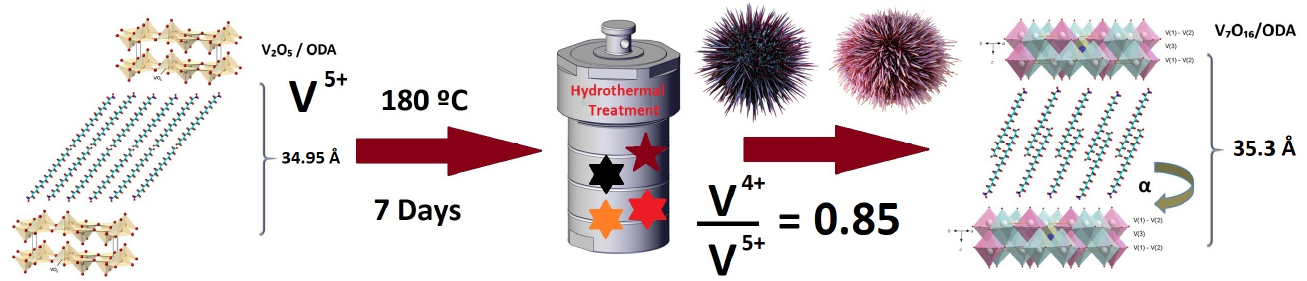
Figure 2. Synthetic procedure to obtain vanadium oxide nanourchins, (VOx-NU), using VO(OCH(CH 3 ) 2 ) 3 V 5+ precursor and 1-octadecylamine in a sol–gel process enhanced with hydrothermal treatment, where V 5+ reduces 46.0% into V 4+ , morphing from V 2 O 5 to V 7 O 162 − structural lattice.